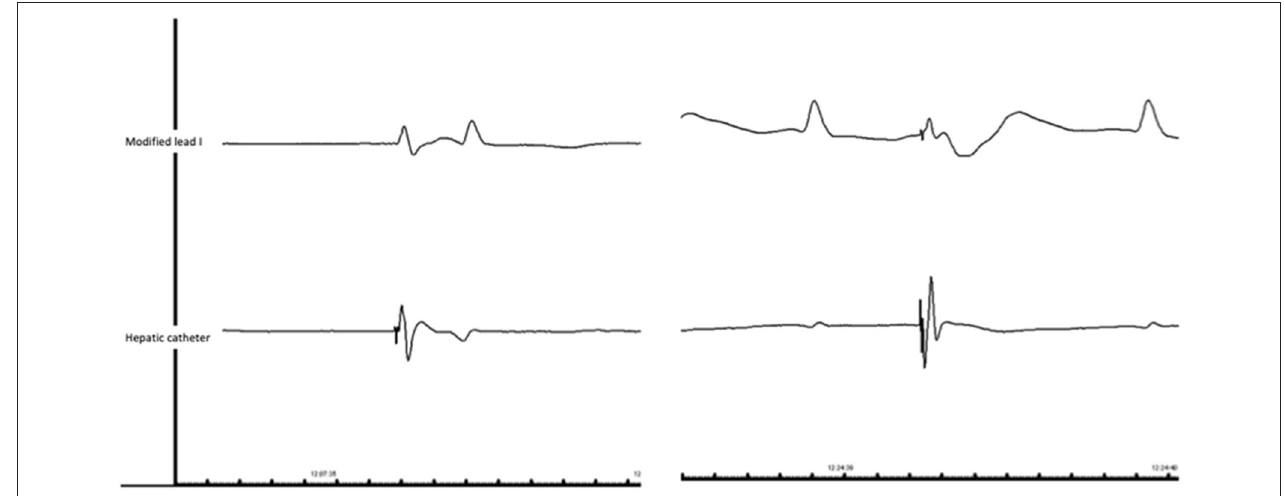
FIGURE 2 | 2 most common patterns of CMAP in our population. Left : First pattern: biphasic signal recorded in surface electrode with CMAP/QRS ratio about 1; biphasic and sharp signal recorded with hepatic catheter (Patient#26). Right : Second pattern: monophasic and slurred signal recorded in surface electrode with